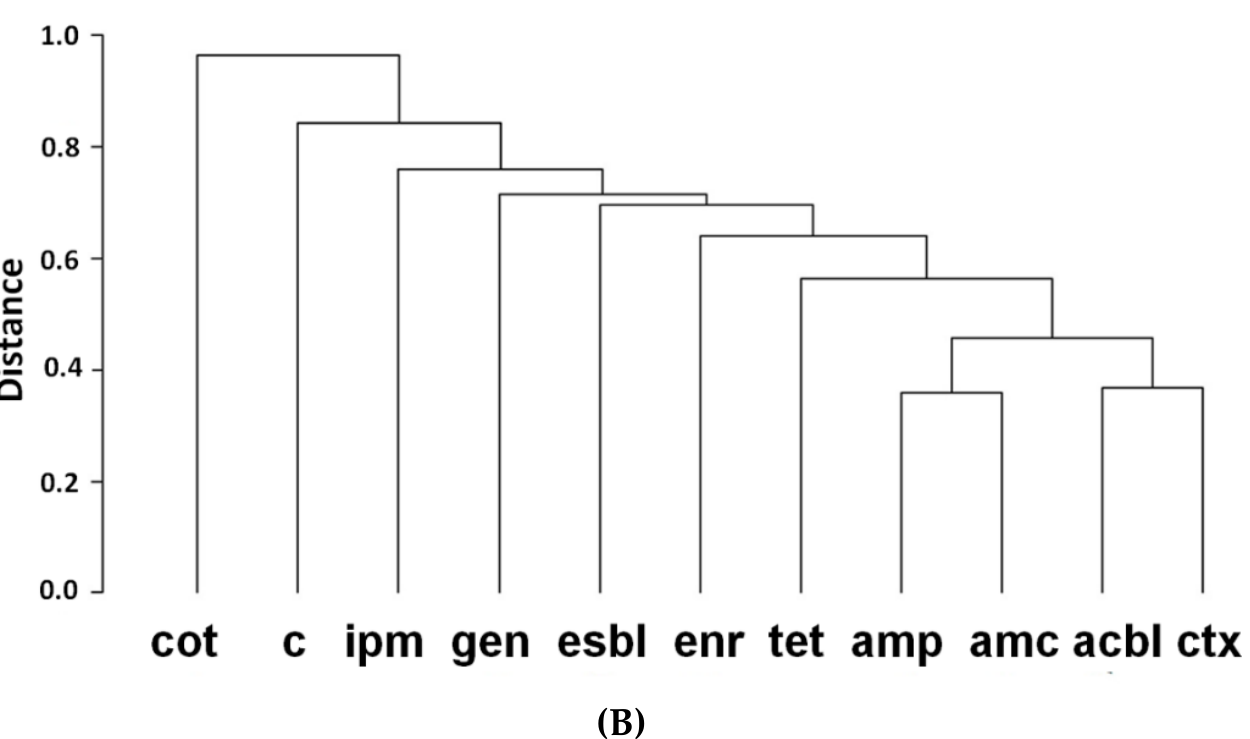
Figure 1. ( A ) Association matrix reflecting the strength and direction of the relationships between individual antimicrobials based on the resistance profile of the Escherichia coli isolates investigated in this study. Goodman-Kruskal tau association was used to depict the association matrix highlighting only the antibiotics having statistically significant ( p < 0.05) association with ACBL and ESBL in red frame. (B) Hierarchical tree of nine antibiotics and β -lactam-resistant mechanisms (ESBL and ACBL) based on the resistance profile of the Escherichia coli isolates investigated in this study using the cluster analysis derived from UPGMA agglomeration method and dissimilarity structure pro- duced by Euclidean distance matrix (COT — cotrimoxazole; C — chloramphenicol; IPM — imipenem;